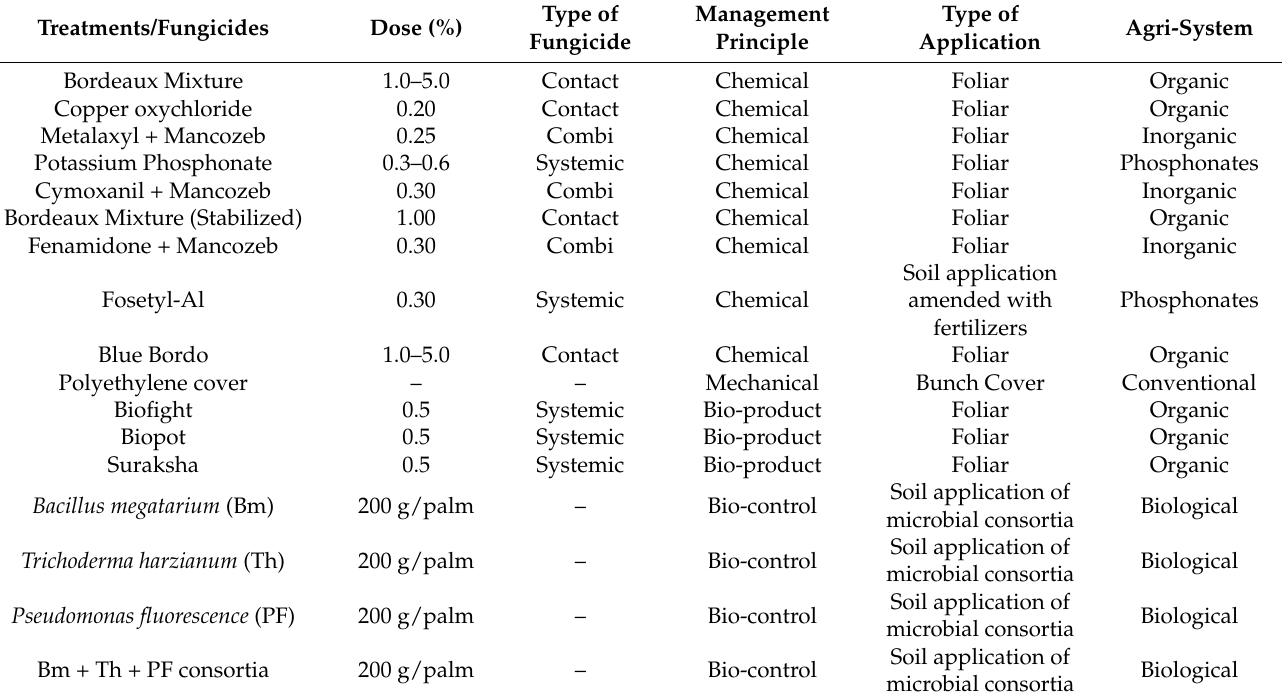
Table 1. Information about the evaluated treatments against fruit rot disease (FRD) with multi- environment